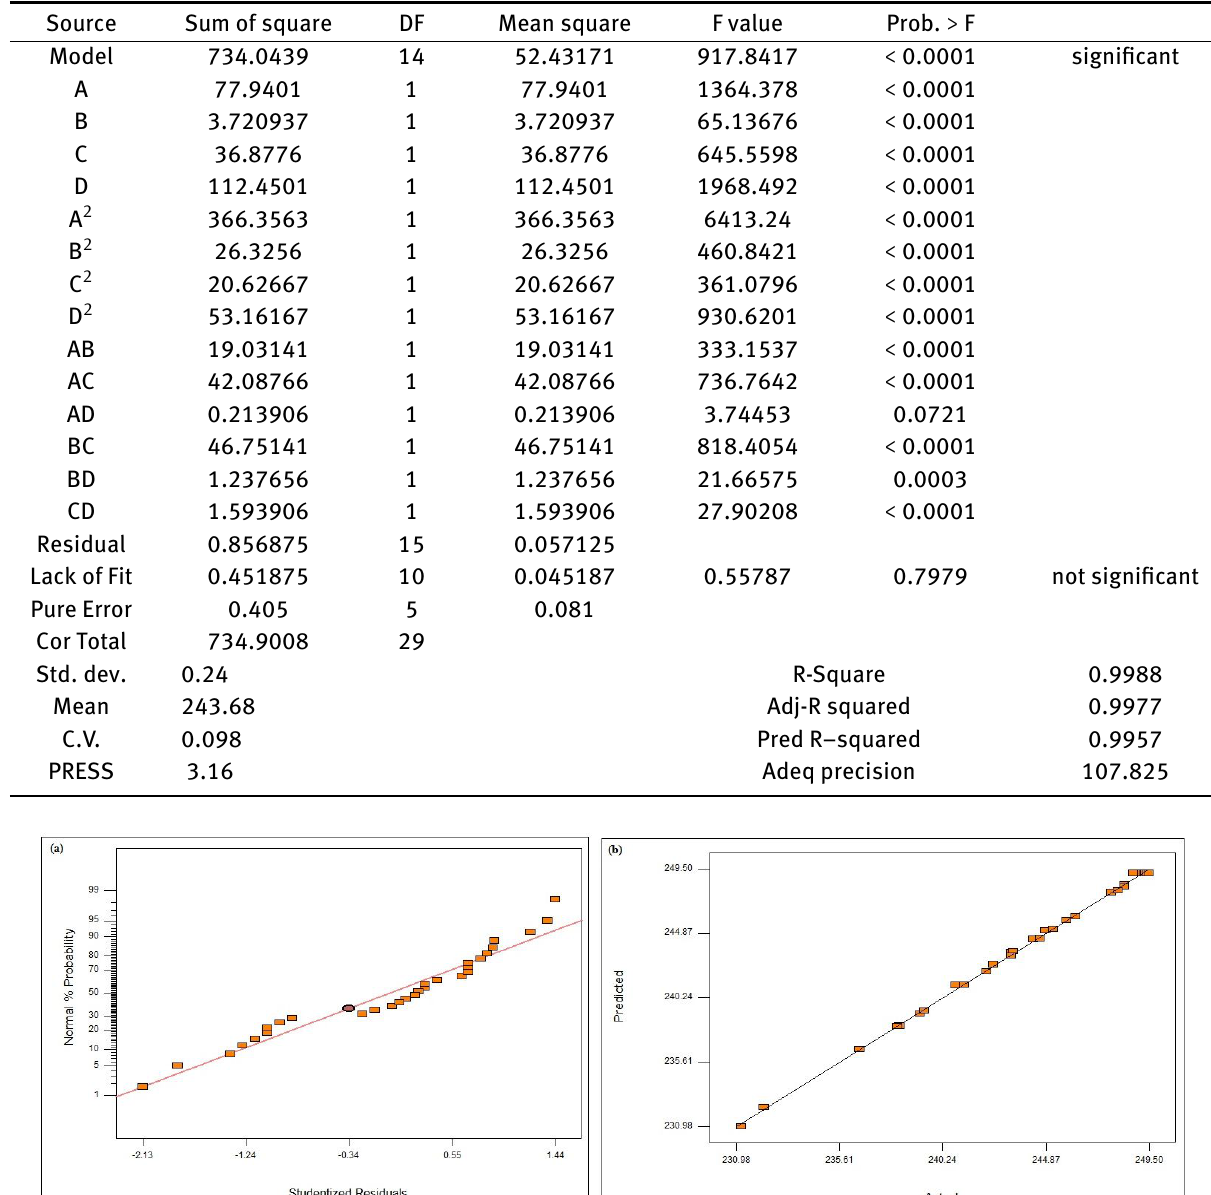
Table 8: ANOVA Table for Tensile strength